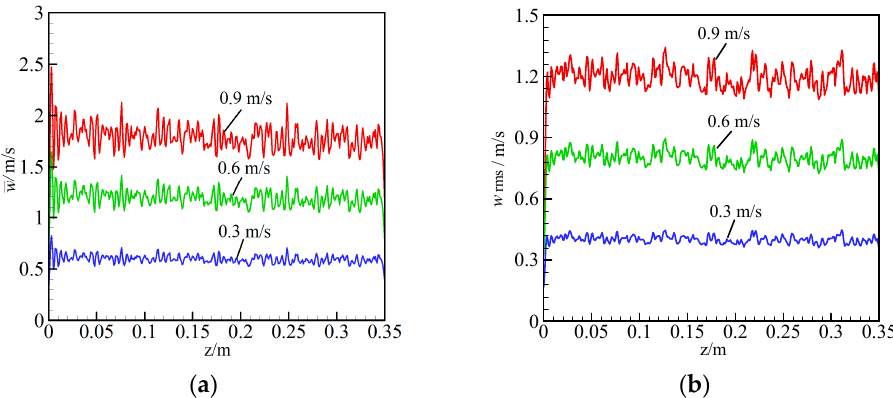
Figure 7. Axial velocity and its root mean square for the cold flow in the burner for three different air velocities. ( a ) w /m/s. ( b ) w RMS /m/s.